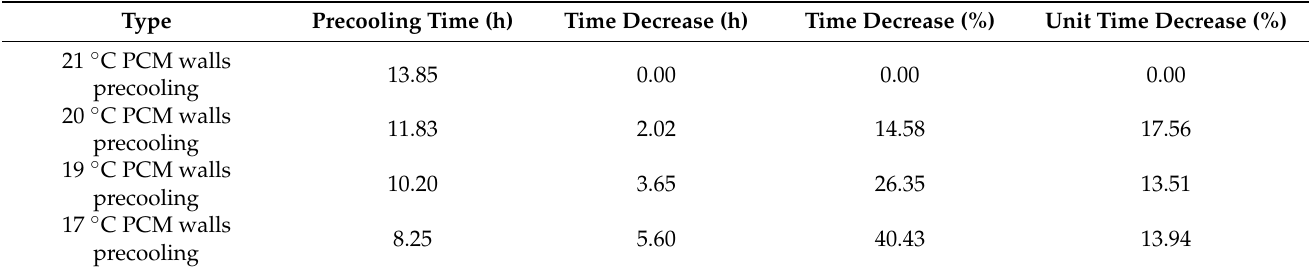
Table 4. Precooling times at various precooling setpoints temperatures.